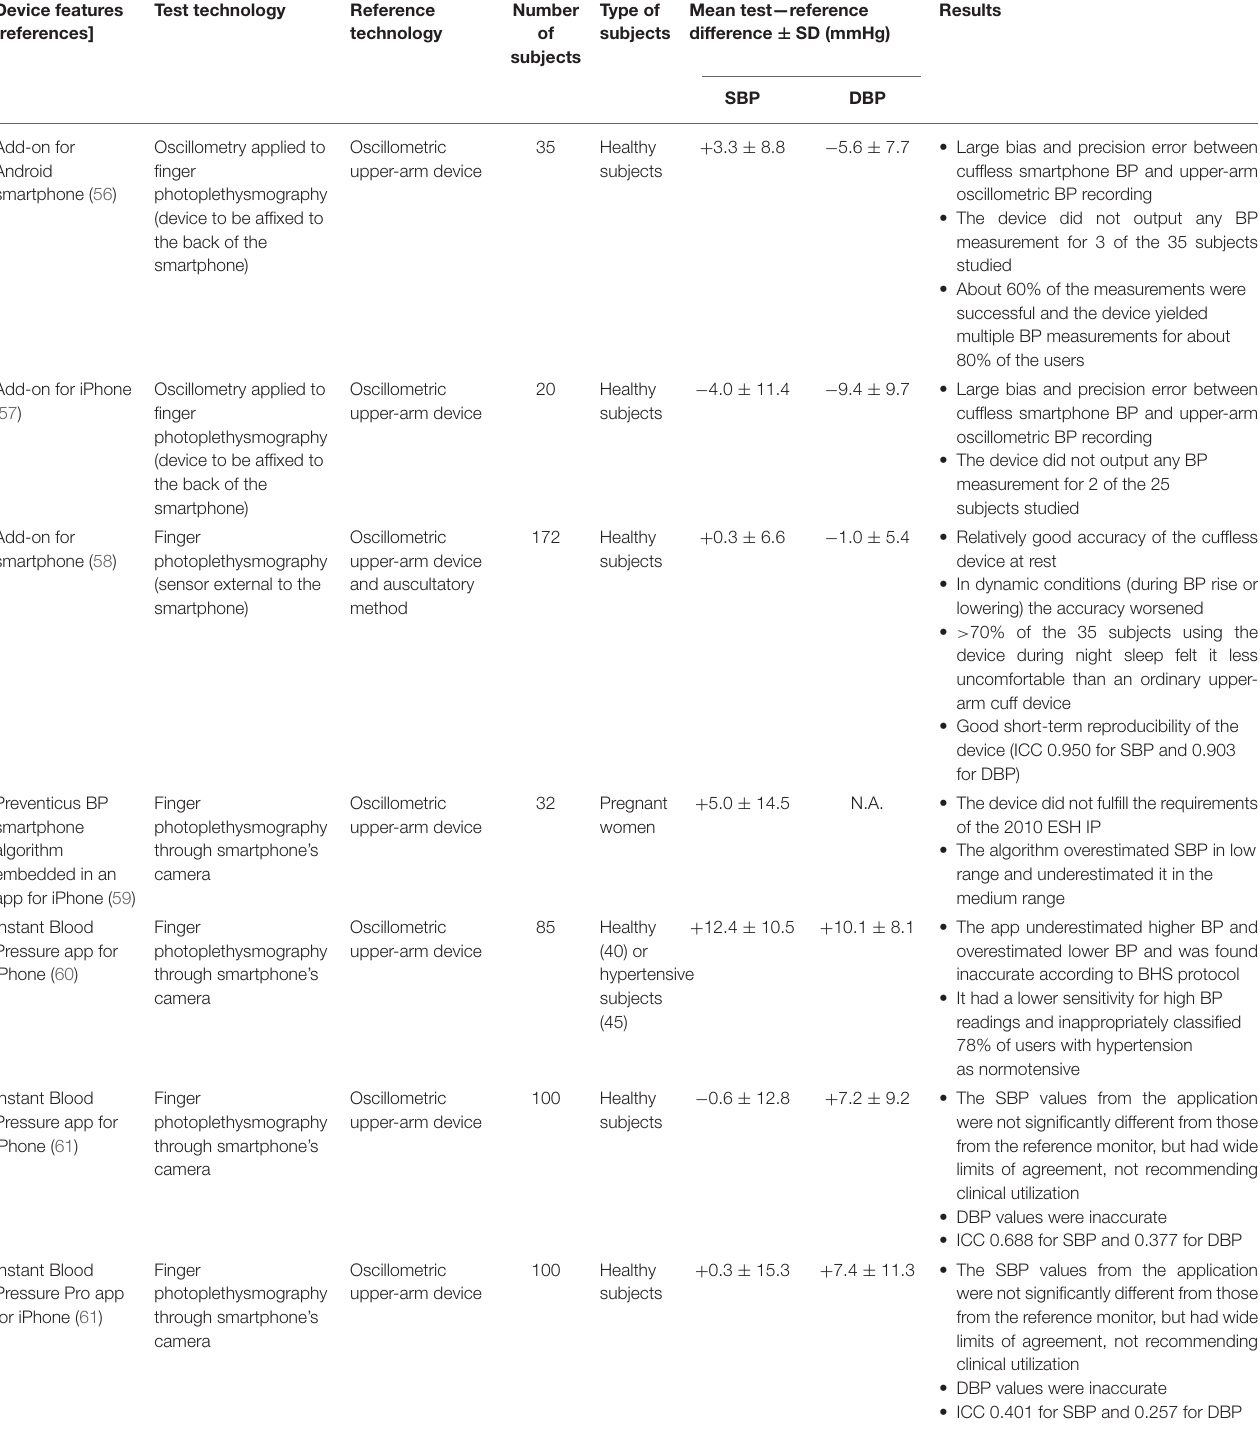
TABLE 6 | Validation studies assessing the accuracy of BP measurements provided by cuffless devices or apps for smartphones. Device features